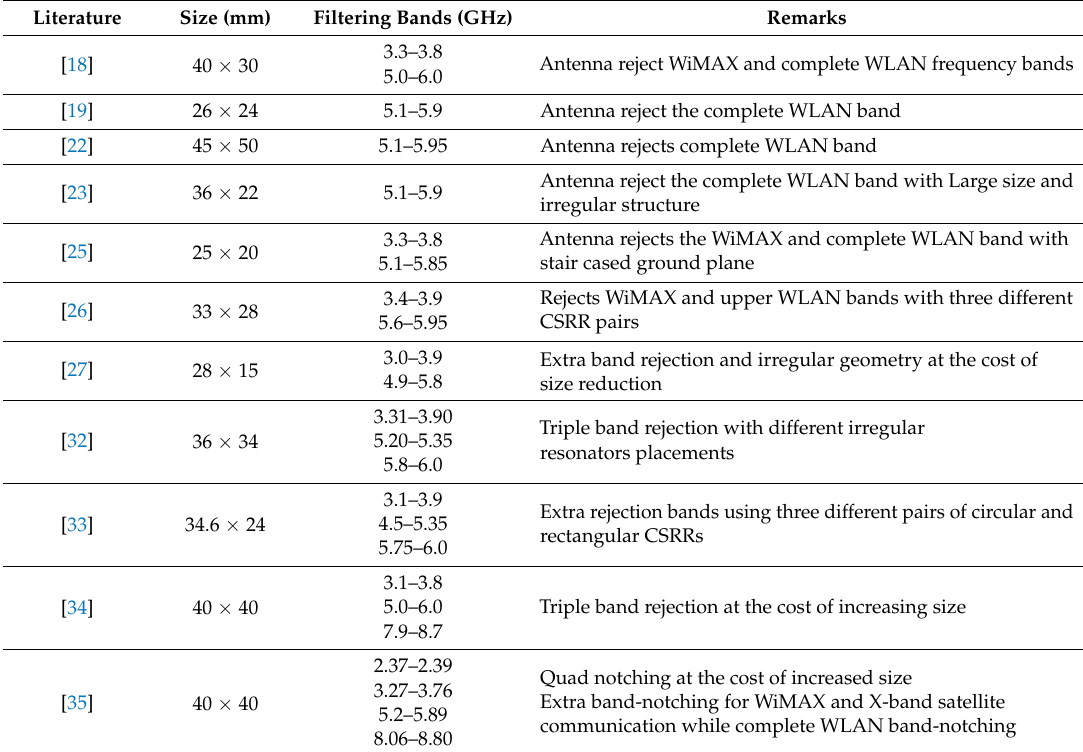
Performance comparison of the proposed antenna with another recently reported state-of-the-art